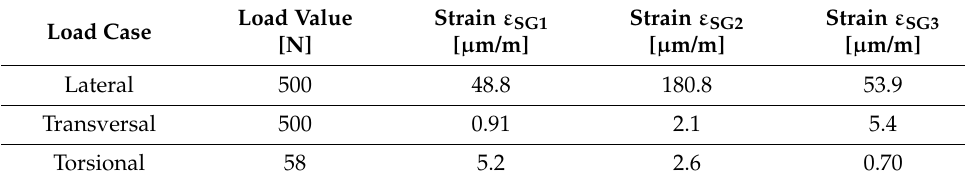
Table 9. Computed strains on the outer and inner surface of the composite hood